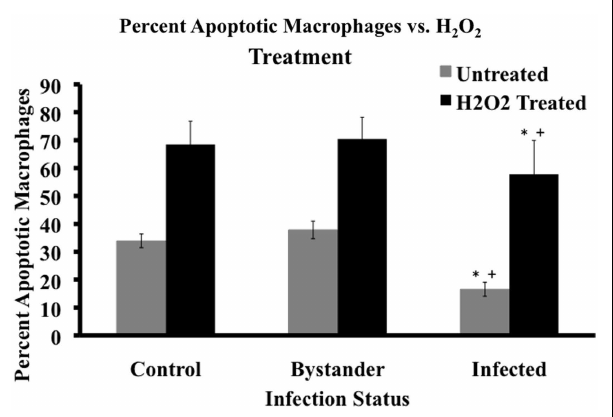
FIGURE 2 | Cell status post apoptotic induction. Percentage of apoptotic macrophages in populations of MAP-infected, bystander, and uninfected control cells was determined by flow cytometry after 20min of 100 µ M H 2 O 2 treatment. Bars represent the average results of MDM cultured from six healthy Holstein cattle. Gray bars represent the percentage of apoptotic cells pre-treatment, while black bars represent the percentage of apoptotic macrophages after treatment in the three cell groups. Error bars represent Standard Error of the mean (SEM) between the six biological replicates. A + indicates significantly different from control, uninfected cells at p < 0.05 and *indicates significantly different from bystander macrophages at p < 0.05. pro-survival cells when compared to bystander and control cells ( p < 0.0001 for each sample, data not shown). Bystander cell